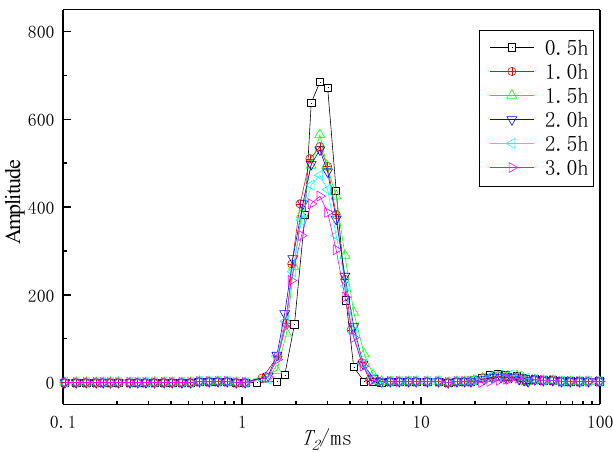
Figure 1. T 2 distribution of blank cement slurry.